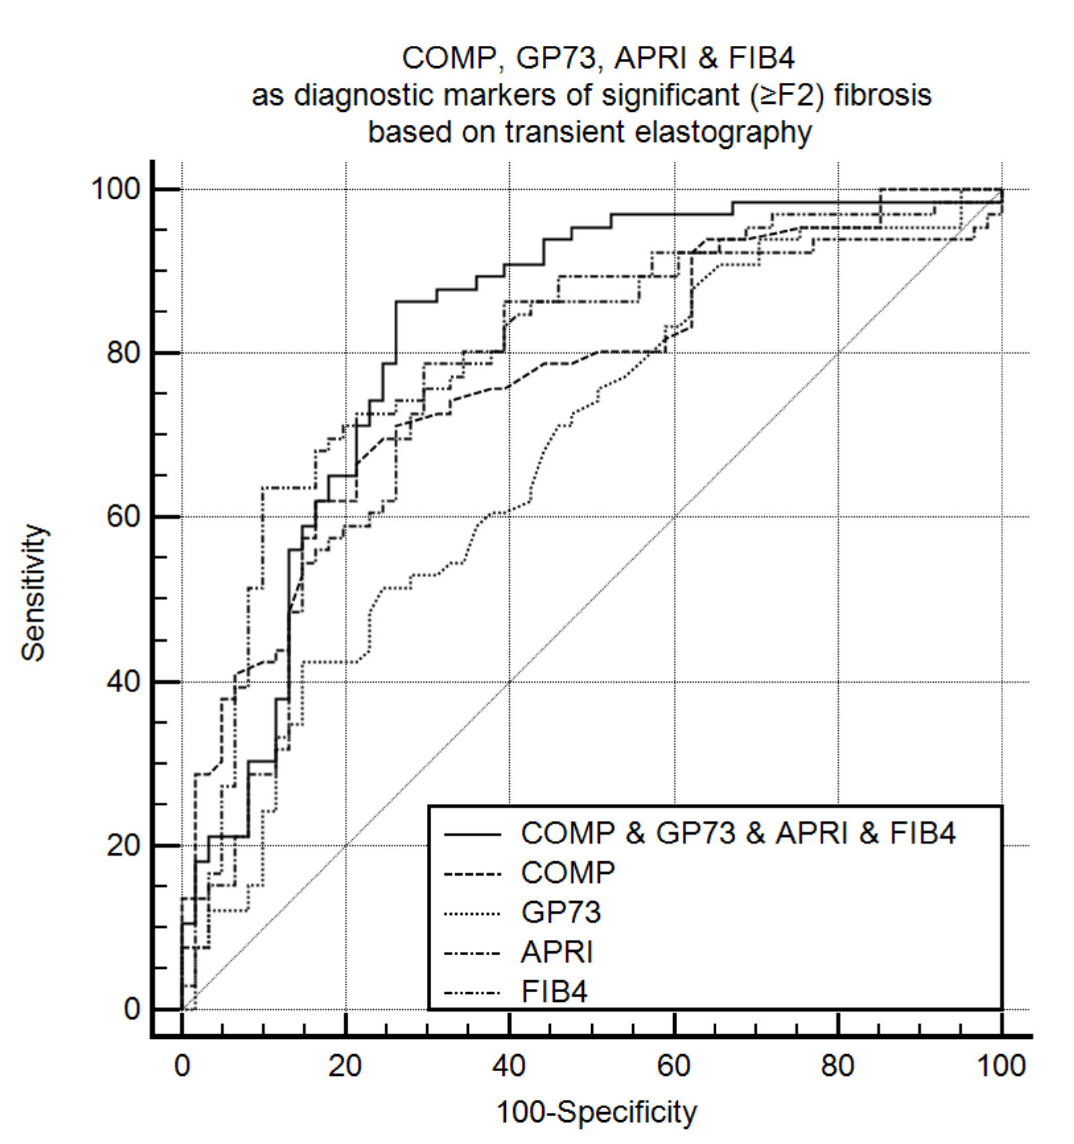
Figure 4. COMP, GP73, APRI, and FIB-4 as diagnostic markers of significant fibrosis ( ≥ F2) according to transient elas- tography ( n = 127). The combination of COMP, GP73, and FIB-4 had the highest diagnostic accuracy [AUC (95% CI): 0.841 0.766–0.900)] compared to each marker alone: GP73 [AUC (95% CI): 0.676 (0.587–0.756); P < 0.001], COMP [AUC (95% CI): 0.772 (0.690–0.842); P = 0.100], APRI [AUC (95% CI): 0.759 (0.675–0.830); P = 0.052], and FIB-4 [AUC (95% CI): 0.802 (0.722–0.868); P = 0.210]. COMP: Cartilage oligomeric matrix protein. GP73: Golgi protein 73. APRI: Aspartate aminotransferase to platelets index. FIB-4: Fibrosis-4. AUC: Area under the